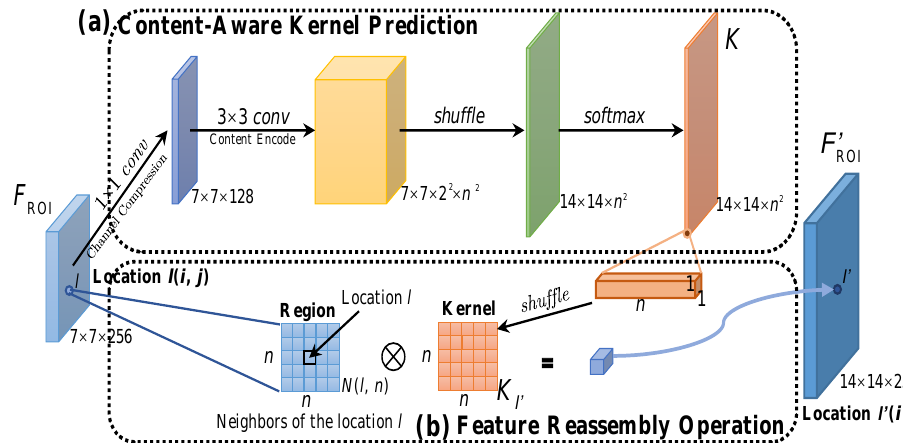
Figure 4. Implementation of the content-aware feature reassembly (CAFR) in the GCIM-Block. ( a ) Content-aware kernel prediction. ( b ) Feature reassembly operation.